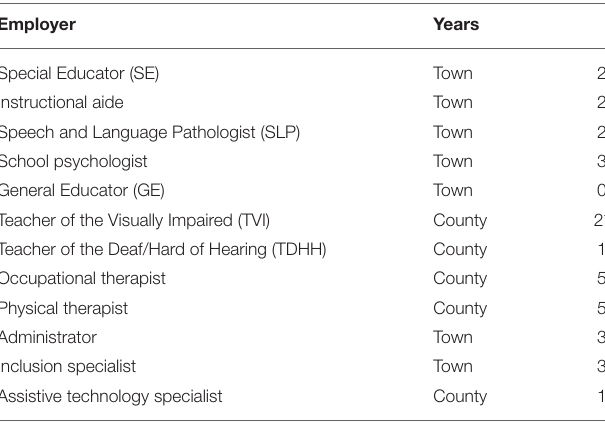
TABLE 1 | Professional profiles of Andy’s team: employer and years supporting Andy at the start of the school year.